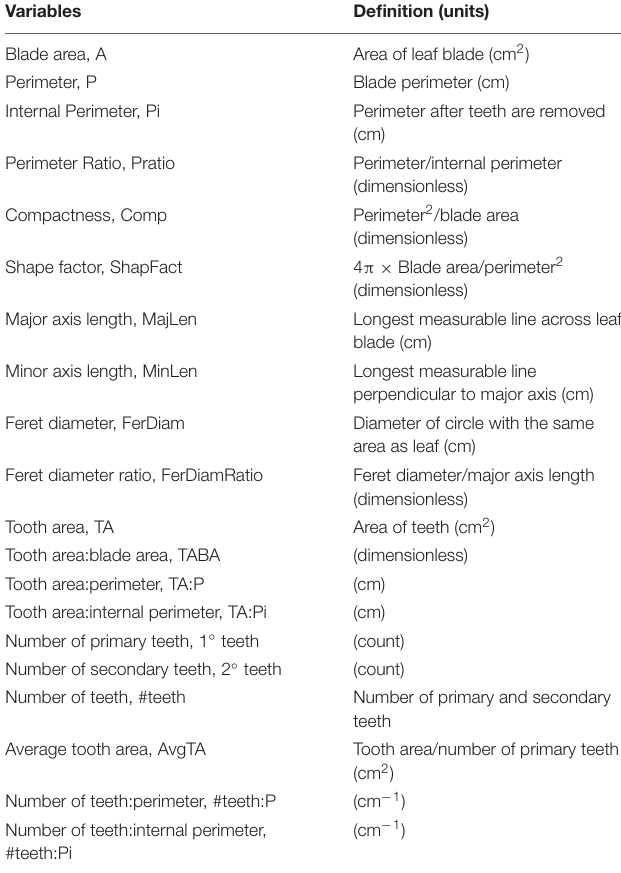
TABLE 1 | Definitions of leaf traits used in this study (Royer et al.,